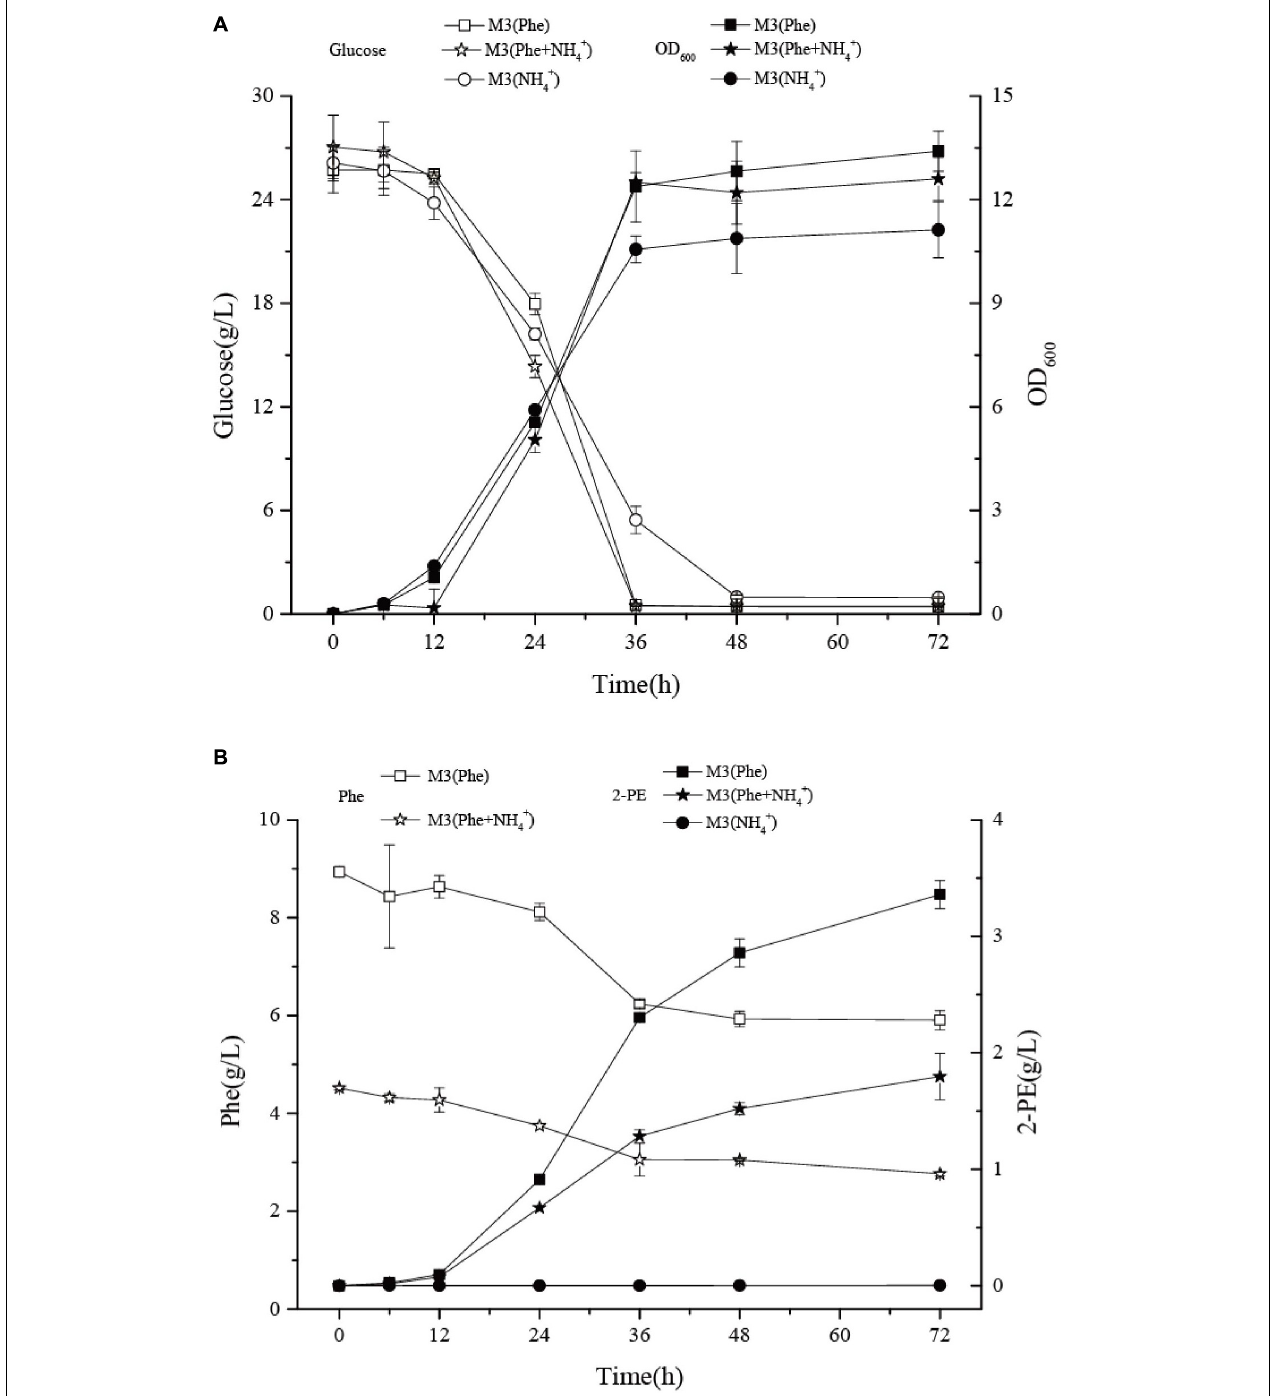
FIGURE 6 | The effects of different nitrogen sources on the growth (A) and 2-PE synthesis of Z. rouxii M2013310 (B) .